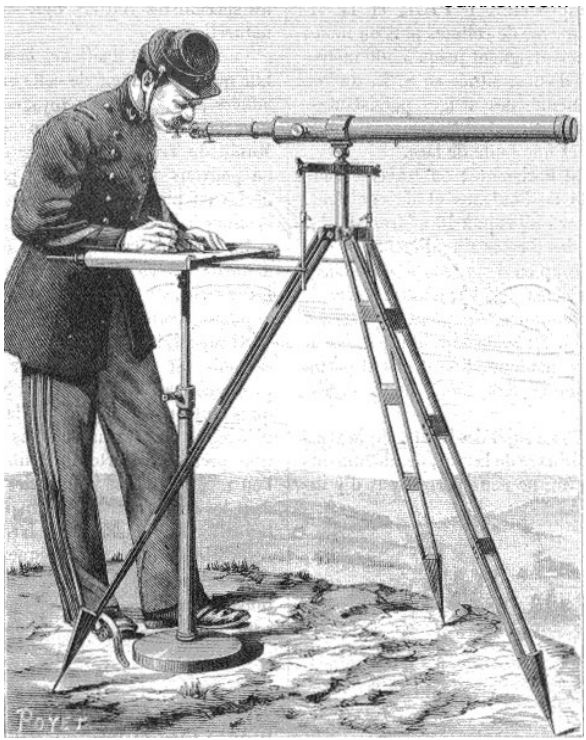
Figure 4. Laussedat’s telemetrograph